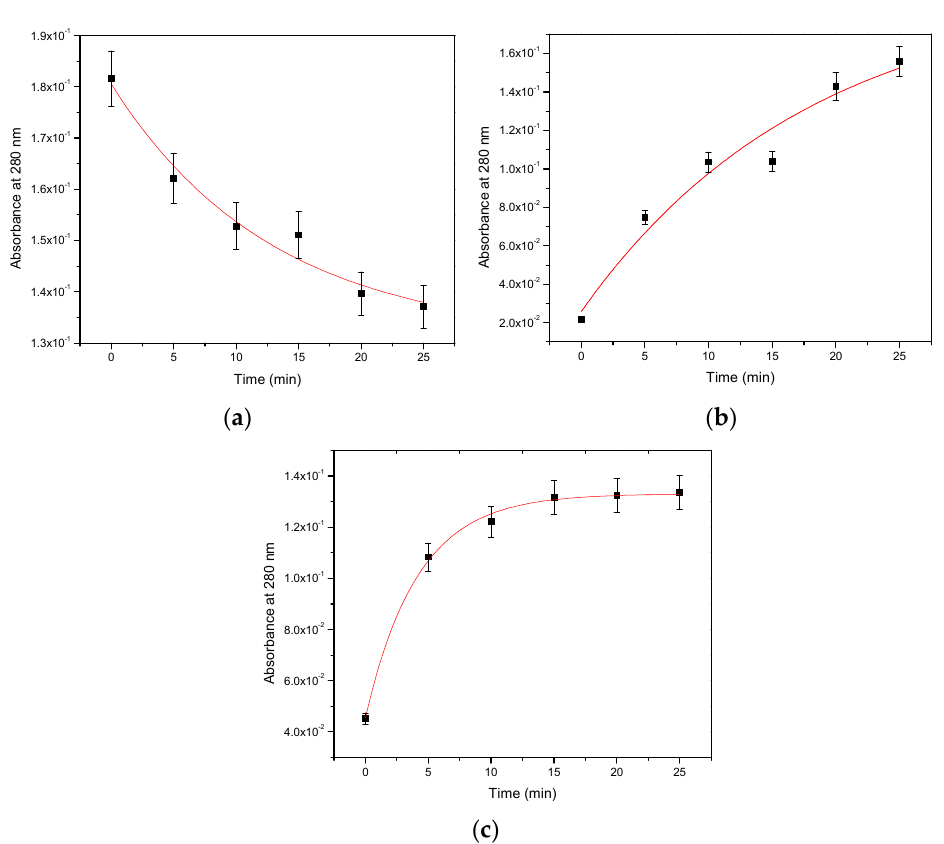
Figure 2. Absorbance at 280 nm of films over time submerged in a solution of ultrapure water spiked with a concentration of EE2 of 10 − 12 M of ( a ) (PAH/GO) 5 , ( b ) (PAH/PAZO) 5 , ( c ) (PEI/PSS) 5 thin films.